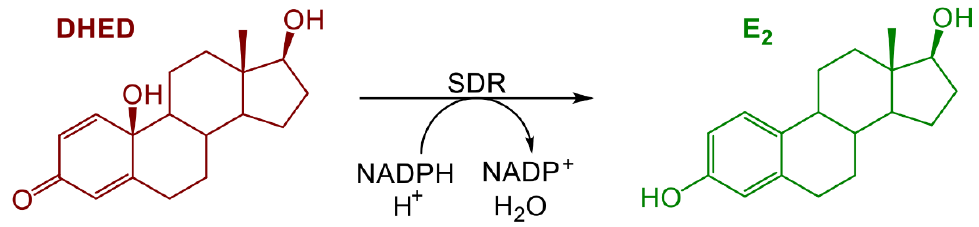
Figure 1. The bioprecursor prodrug 10 β , 17 β -dihydroxyestra-1,4-dien-3-one (DHED) converts to 17 β -estradiol (E 2 ) through an enzyme-catalyzed reduction in the brain (SDR: short-chain dehydrogenase/reductase).